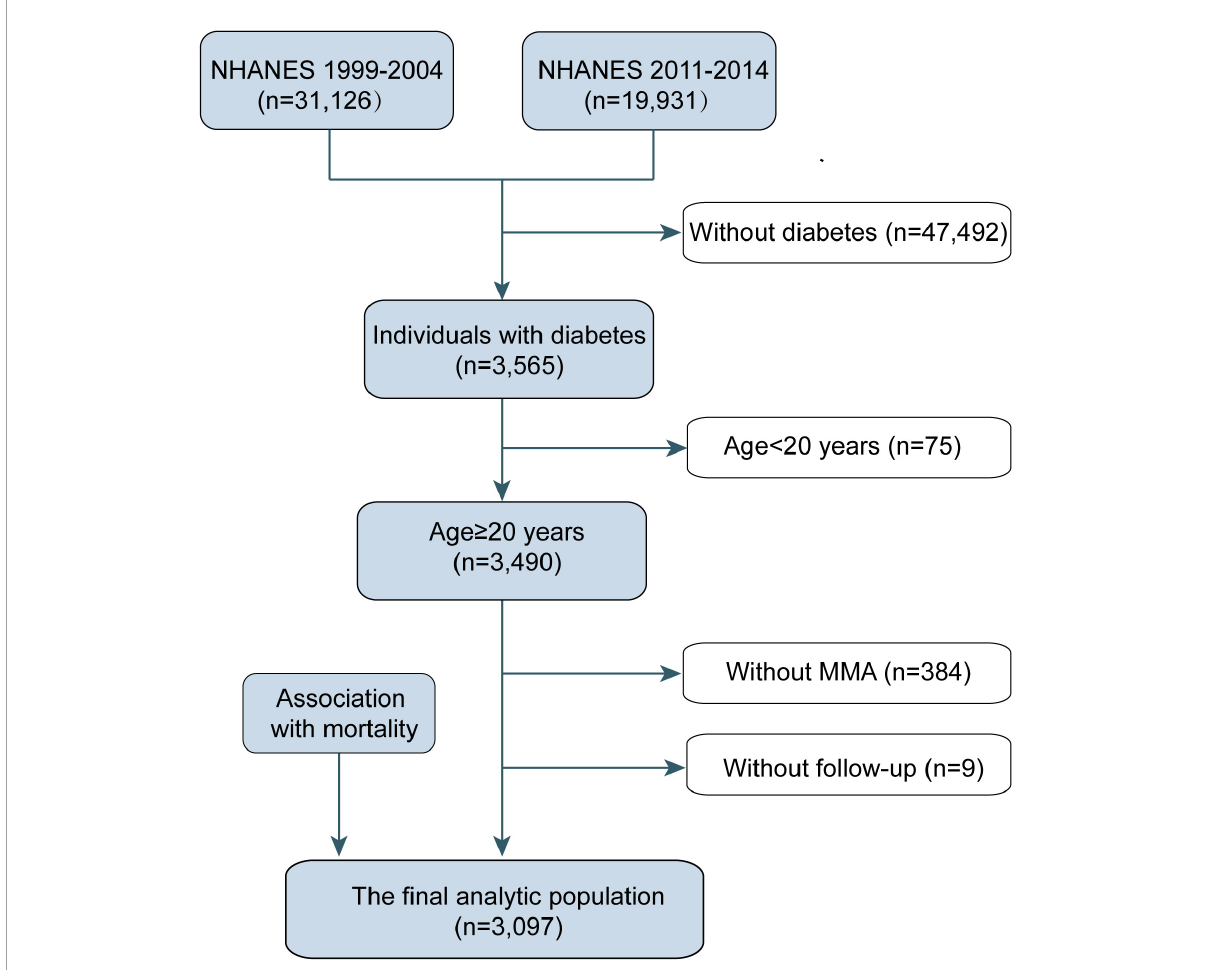
FIGURE1 Eligible participants and those included in the analyses of the associations between circulating methylmalonic acid (MMA) levels and all-cause and cause-specific mortality in individuals with diabetes. NHANES, National Health and Nutrition Examination